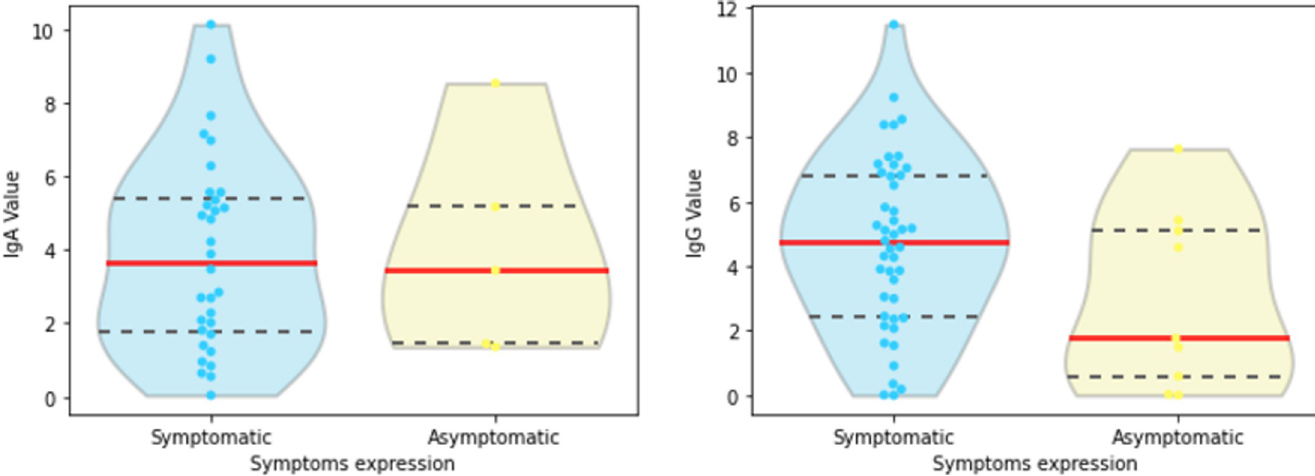
Fig 10. Violin plots of (a) IgA and (b) IgG related to positive results of asymptomatic and symptomatic groups; medians in solid red lines, third quartiles in dashed